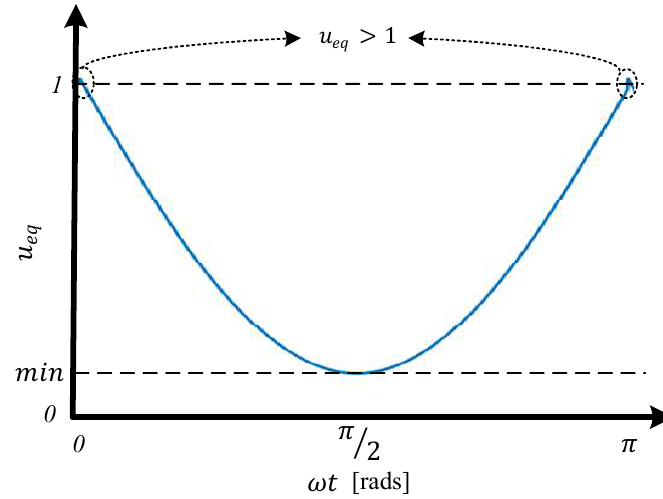
Figure 5. u eq for half cycle of electrical grid.